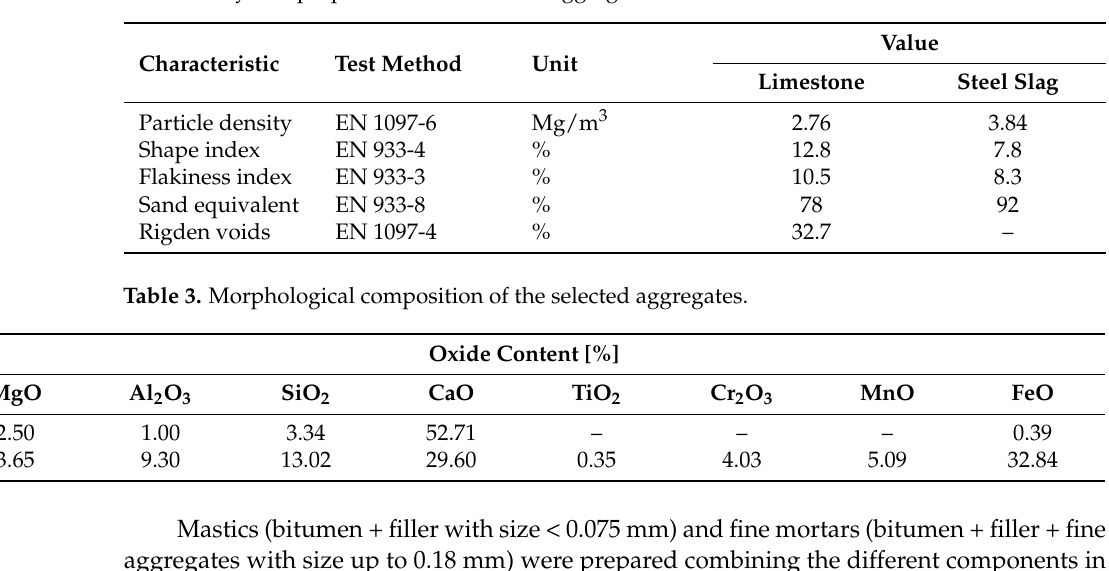
Table 2. Physical properties of the selected aggregates.